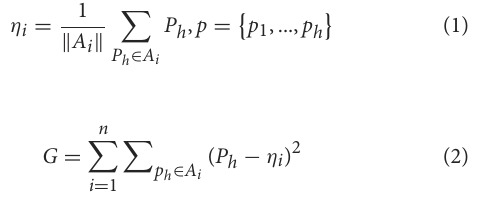
the best model is selected to complete the emotional isolation of the